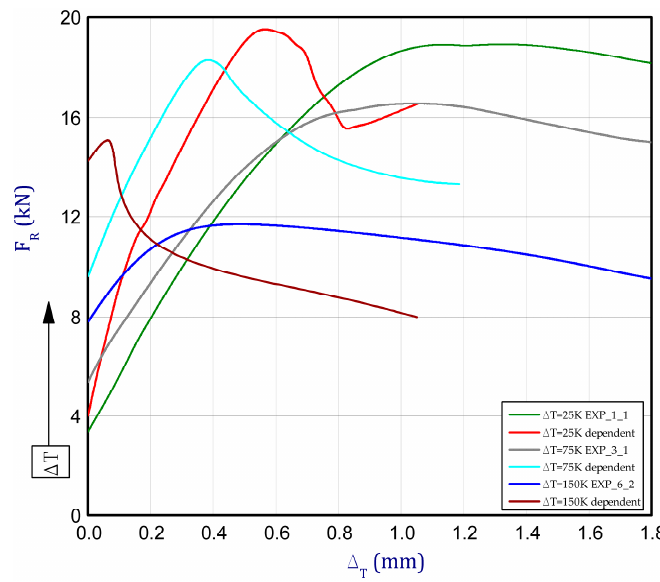
Figure 10. Comparison of obtained curved by FEM and EXP. Table 4. The comparison of recorded modes in total displacements for both methods.